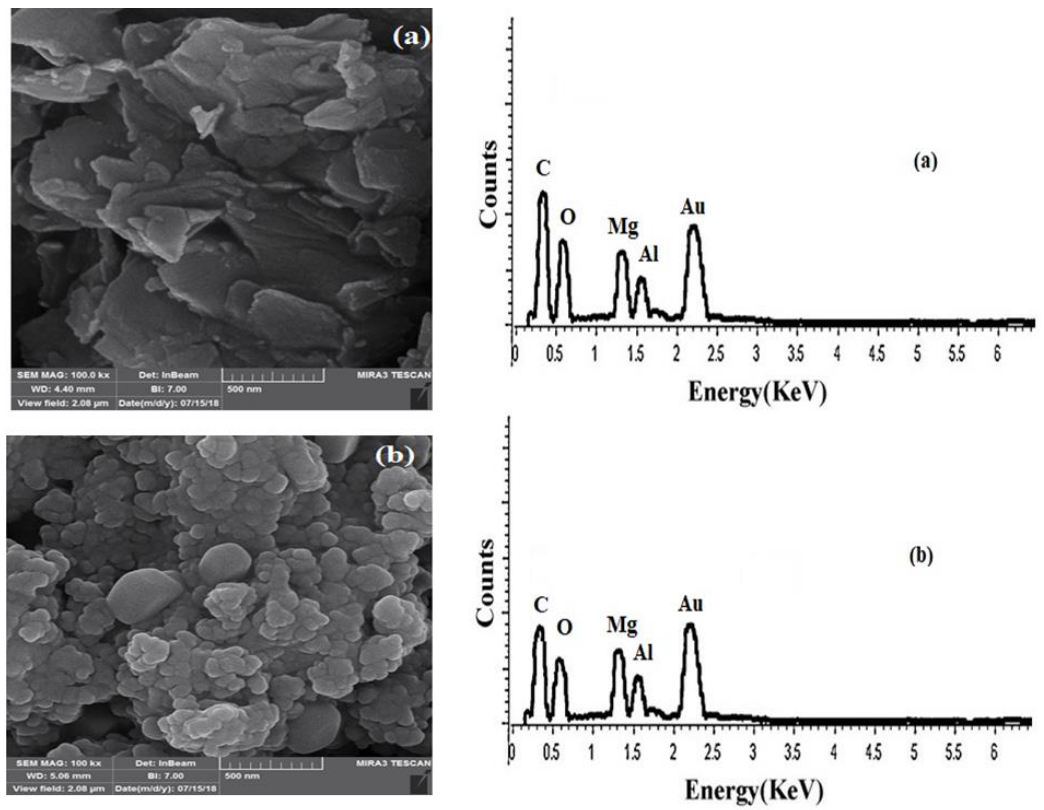
Fig.3. SEM images and corresponding EDS spectrum of (a) Mg-Al–CO